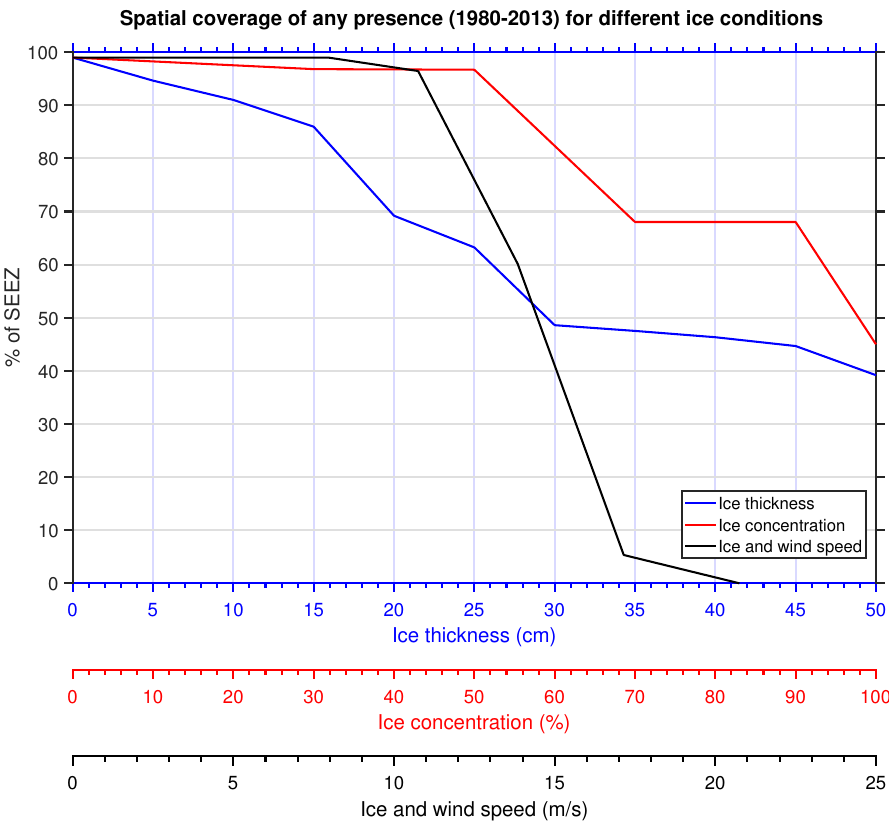
Figure 3. Percent of SEEZ that had presence of different types of ice conditions. Three aspects (ice thickness, ice concentration, and wind speed classes during ice) are represented with three different x-axes in blue, red, and black,